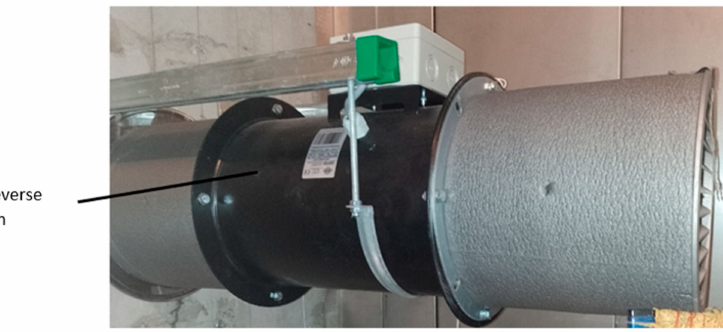
Figure 3. Façade ventilation unit (view from the side simulating external environment